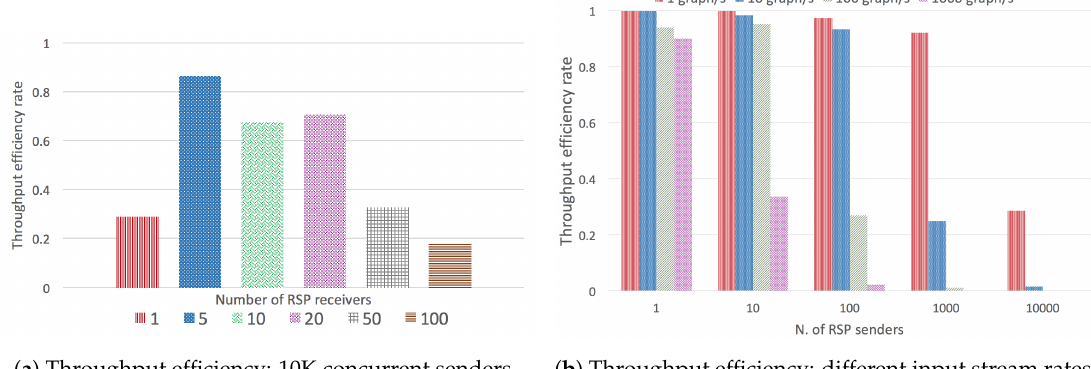
Figure 22. Throughput efficiency vs. number of RSP